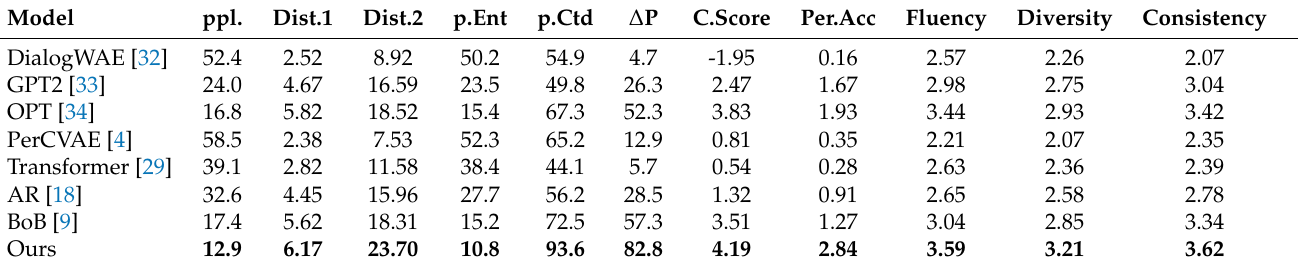
Table 4. Experiment results of PersonalDialog dataset.